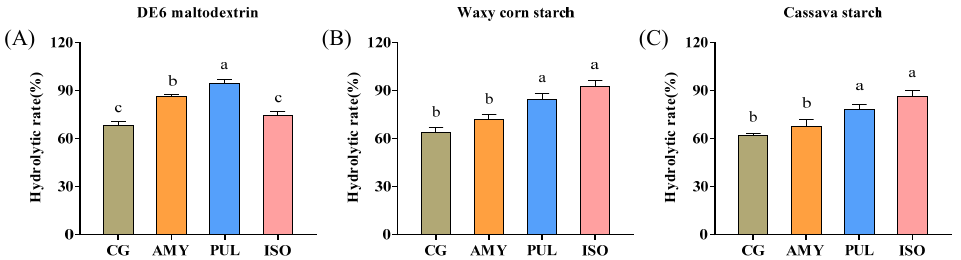
Figure 6. Degree of β -amylolysis limit of hydrolysates obtained by debranching DE6 maltodextrin, waxy corn starch, and cassava starch using AMY, PUL, and ISO, respectively. The substrate of ( A ) was DE6 maltodextrin, ( B ) was waxy corn starch, and ( C ) was cassava starch. Means with different letters within the same group are significantly different ( p < 0.05).